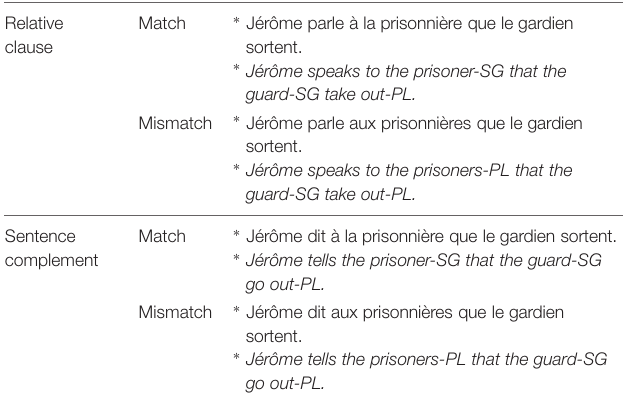
TABLE 2 | Example of an item in the four experimental conditions of Experiment 2.